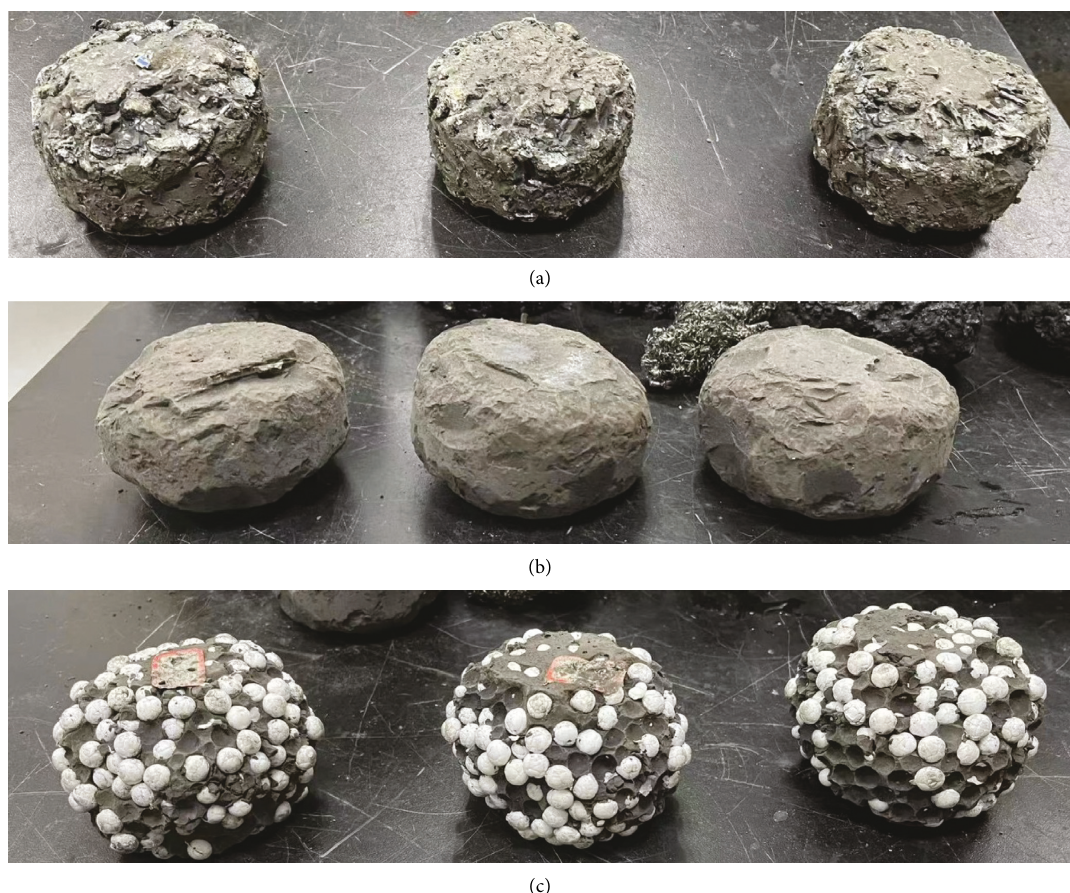
Figure 7: Samples after Cantabro loss testing. (a) CCAM. (b) Cement sample with no balls. (c) Cement sample with balls.